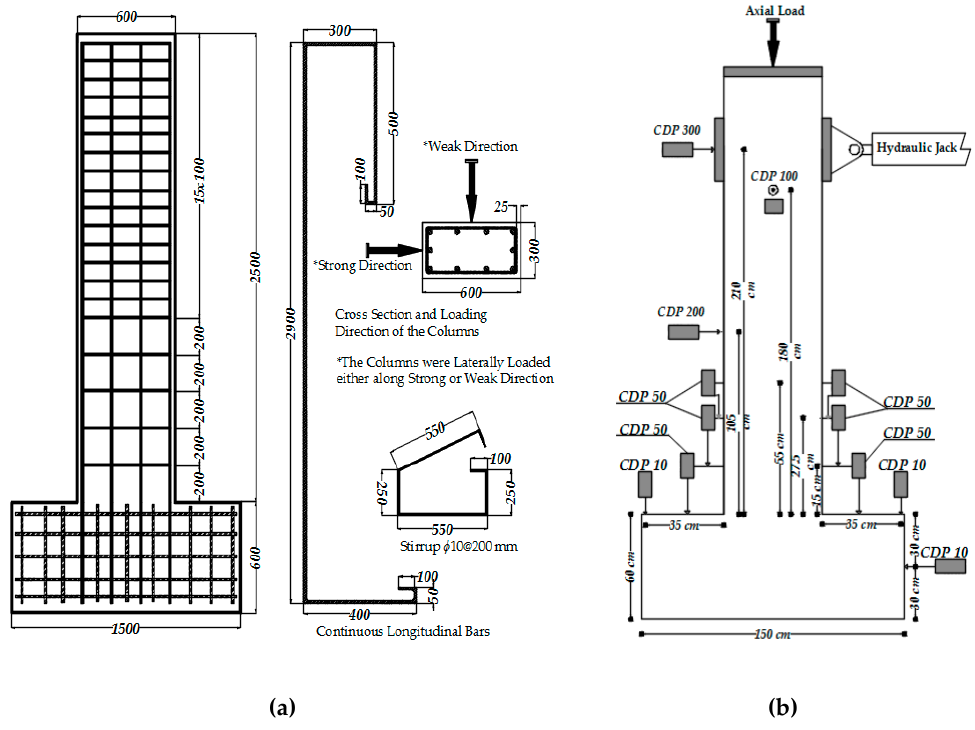
Figure 3. ( a ) Reinforcement scheme (dimensions in mm); ( b ) test setup.